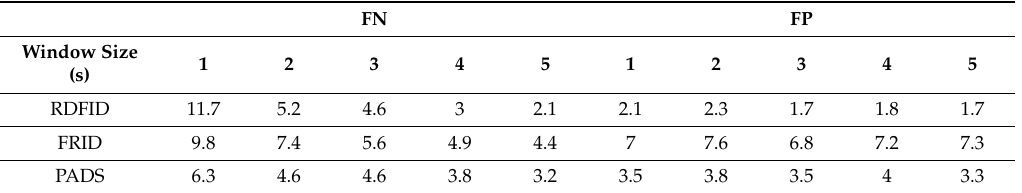
Table 4. FN/FP of human detection under different window sizes (%).